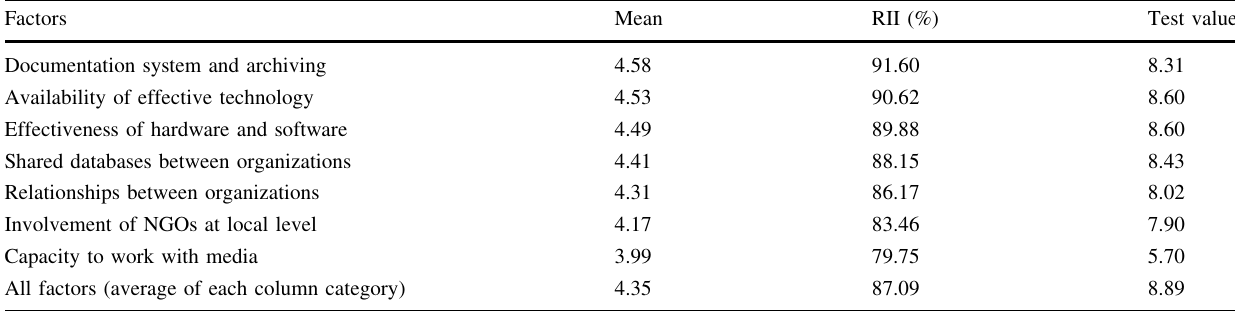
Table 6 Factors influencing communication and coordination in the Gaza Strip